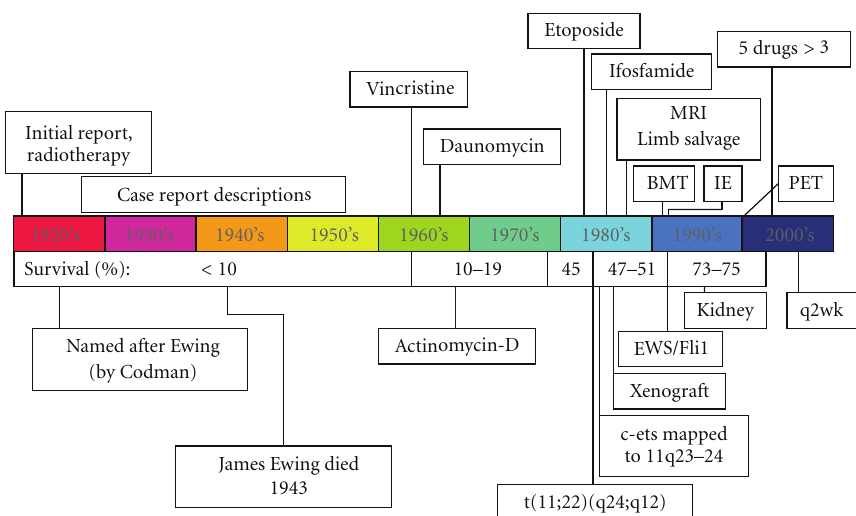
Figure 1: Timeline of historical milestones for Ewing sarcoma. See text for details. Survival data for children diagnosed at age < 15 years old are from Rosen et al. [6] and from the Surveillance, Epidemiology and End Results 9 registries as summarized in the work of Smith et al. [7].